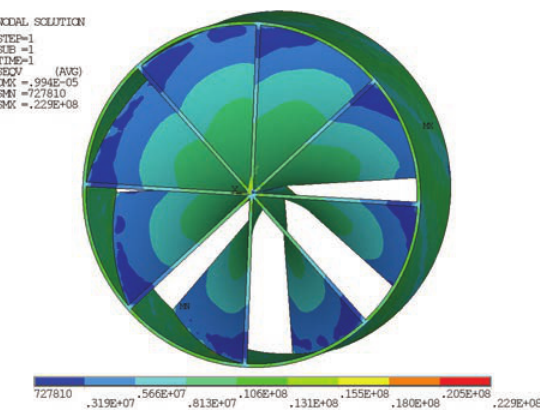
Figure 9. Von Misses distribution of 8A impeller. Fig.9.Von Misses distribution of 8A impeller Fig.9.Von Misses distribution of 8A impeller